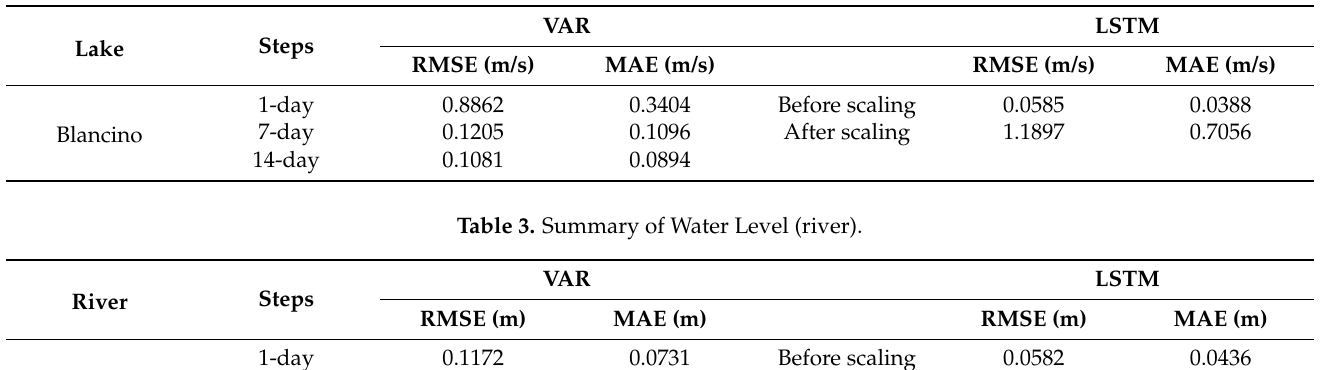
Table 2. Summary of Flow Rate (lake).